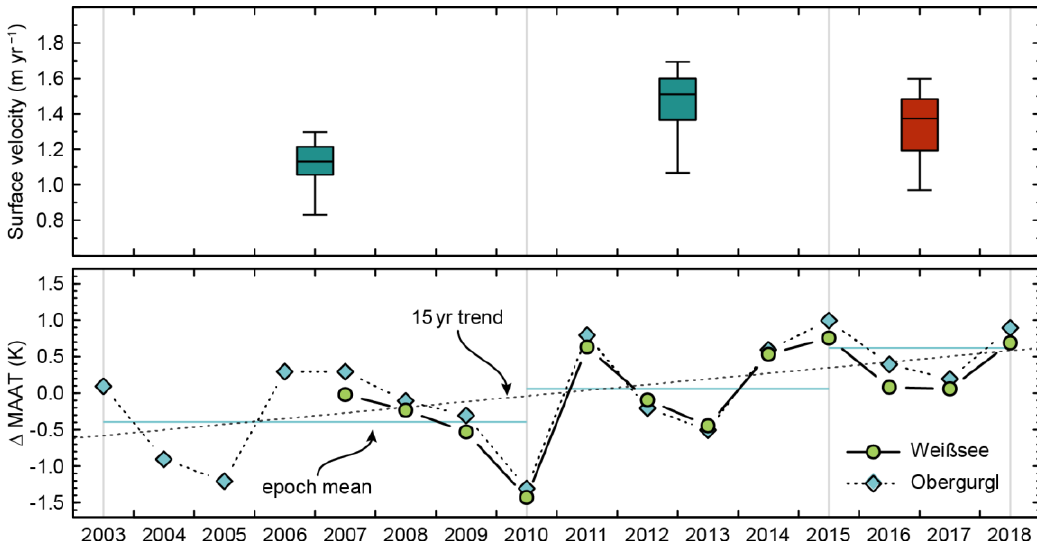
Figure 10. Horizontal surface velocities on the southern lobe of the Kaiserberg rock glacier (RG12) (upper panel) in relation to deviations in mean annual air temperature (MAAT) from mean over entire time-series (lower panel). Average rock glacier velocities were tracked in image-pairs from airplane survey flights for the epochs 2003 to 2010 and 2010 to 2015 (dark green) and in a combination of airplane survey data and UAV-derived imagery for 2015 to 2018 (dark red), respectively. Air temperature is shown as the deviation from MAAT over the entire observation period of the respective station; data from Weißsee meteorological station, Kaunertal courtesy of Tiroler Wasserkraft AG (TIWAG) and data from Obergurgl meteorological station, Ötztal courtesy of Zentralanstalt für Meteorologie und Geodynamik (ZAMG).